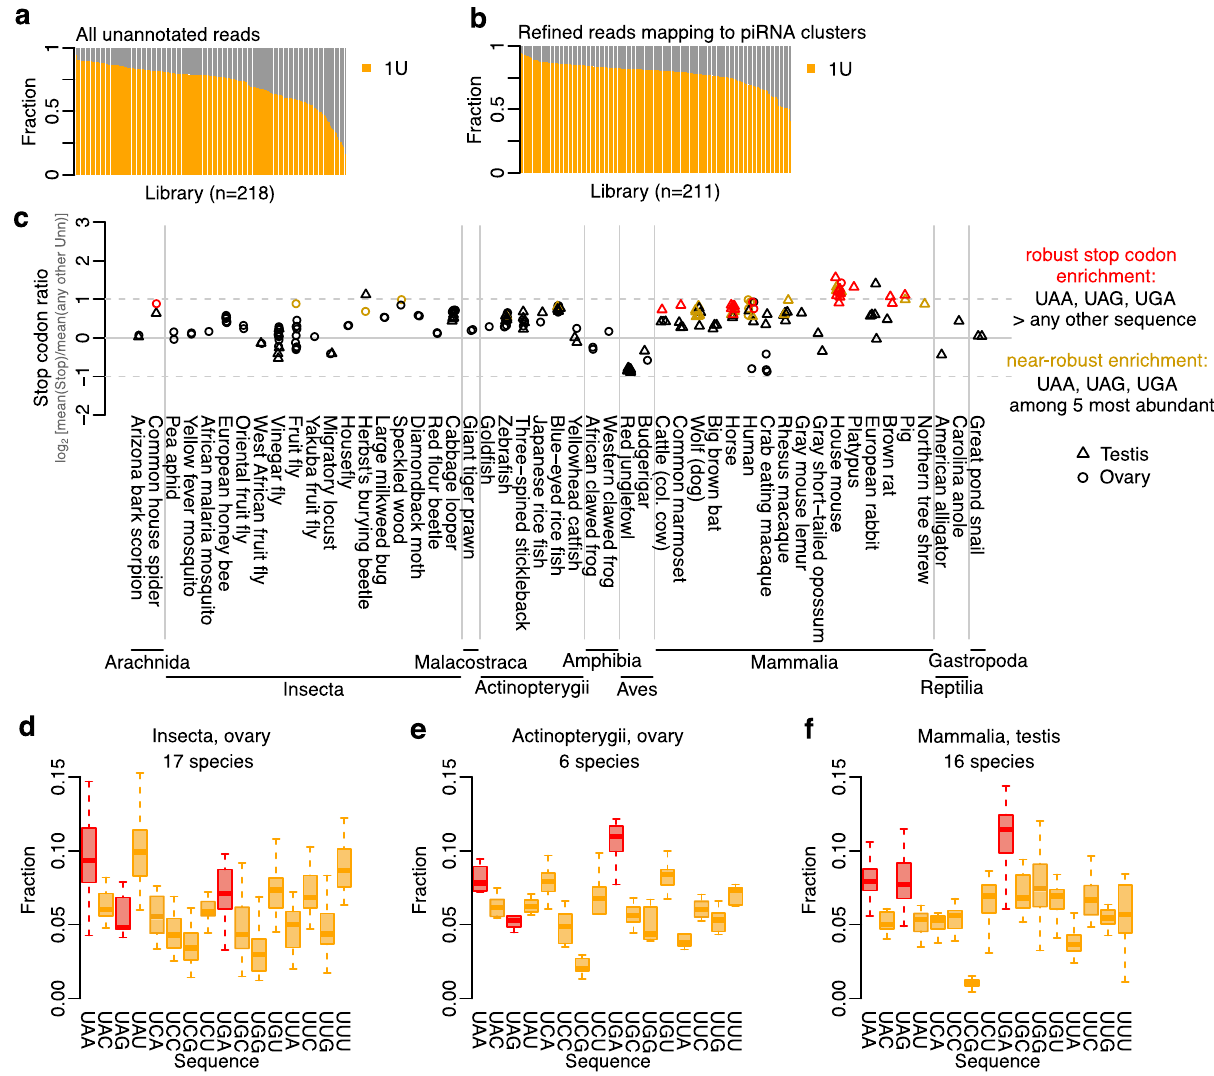
Fig. 6 Stop codon enrichment is conserved across mammals. a , b Bar plots showing 1U across piCdb libraries. Showing either ( a ) all unannotated (i.e. piRNA) reads, or ( b ) unannotated reads mapping to piRNA clusters (see methods for details). c Stop codon ratio per testis (triangle) and ovary (circle) library calculated as mean frequency of stop codons vs mean frequency of all other Unn sequences. Signal shown on a log 2 scale. Libraries with robust (red) or near-robust (yellow) stop codon enrichment are indicated. d – f Boxplots showing relative fraction of Unn sequences in insect ovary ( d ), ray- fi nned fi sh ovary ( e ), or mammalian testis ( f ). Each species is represented as one data point in the boxplots, and multiple libraries from the same species were averaged. The three largest groups are shown here, see also Supplementary Fig. 9. Boxplots show median (central line), interquartile range (IQR, box), and minimum and maximum values (whiskers, at most 1.5*IQR). Source data are provided as a Source Data fi